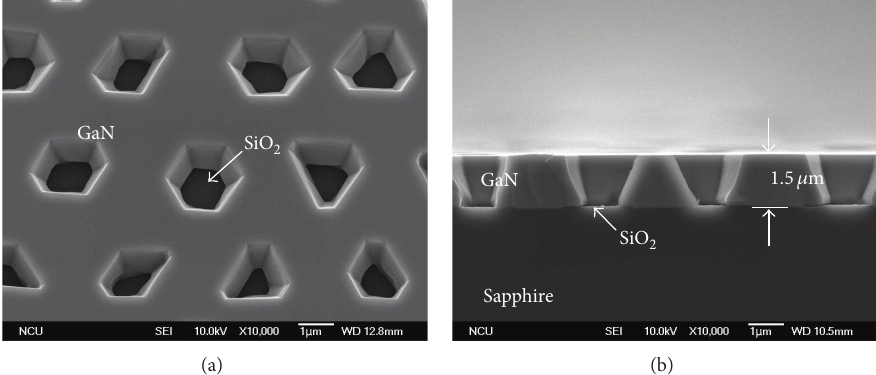
Figure 4: (a) Tilted and (b) cross-sectional SEM images of the sample-R GaN epitaxial layers after Step-1 and Step-2 growth in the IFELOG